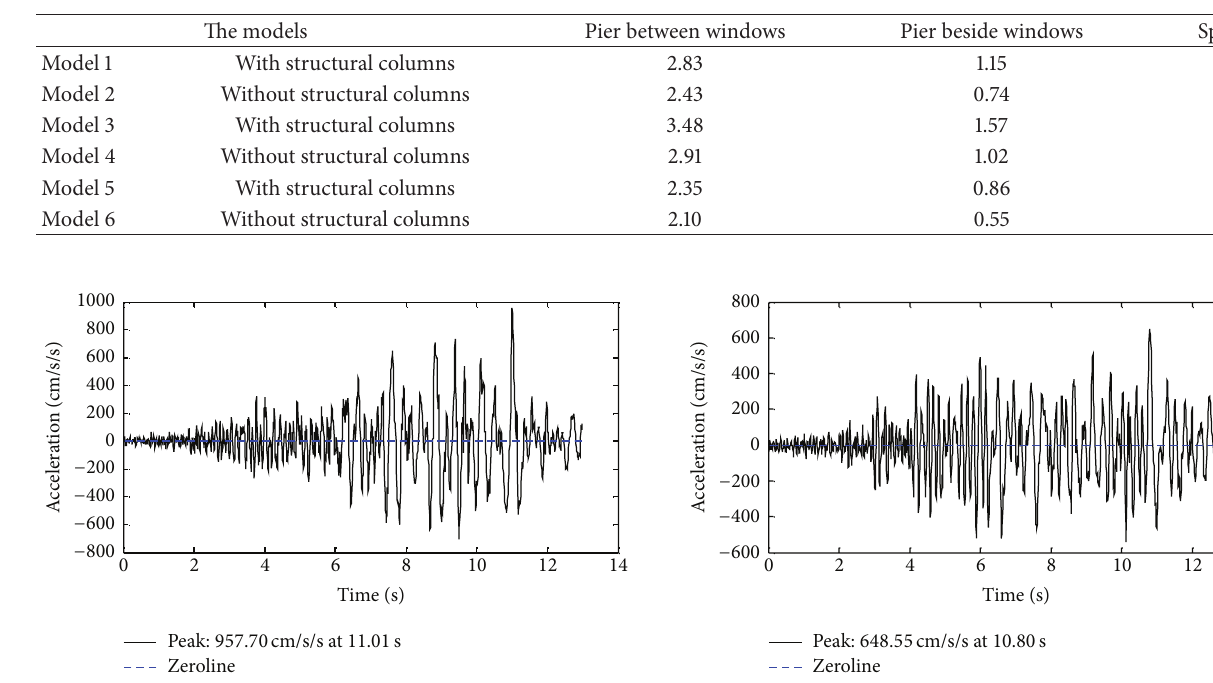
Table 3: The stiffness of pier between windows and spandrel (1 × 10 8 N/m).